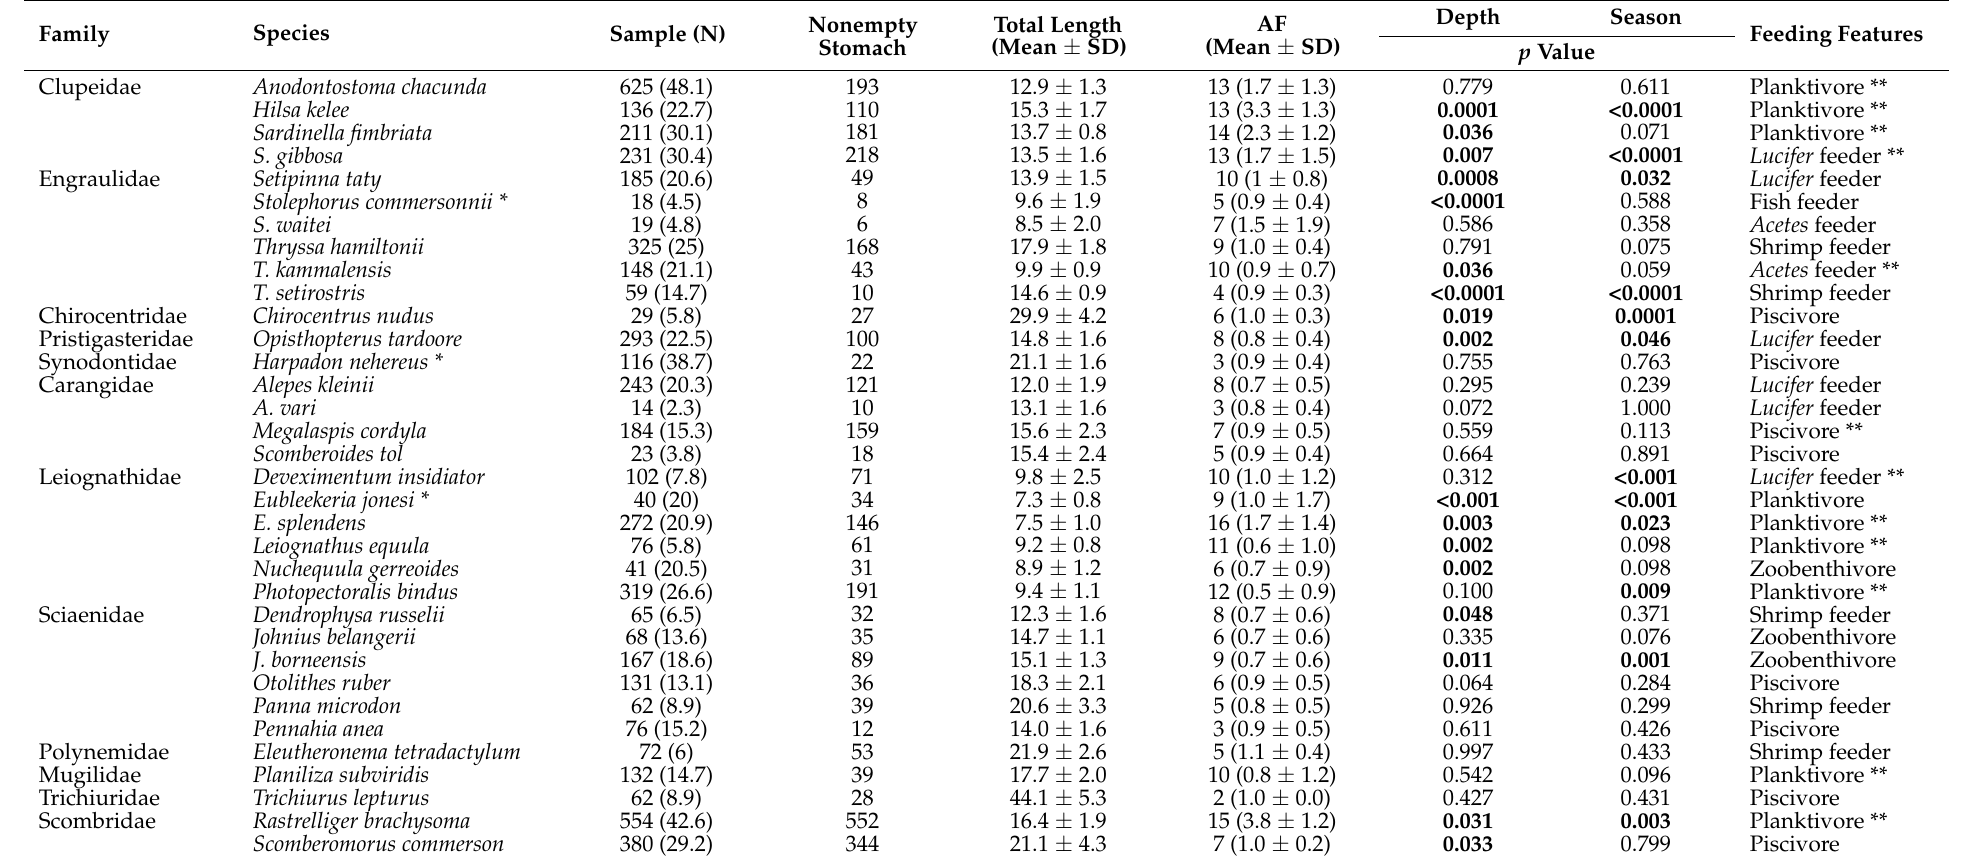
Table 1. Feeding habit and occurrence of anthropogenic debris by fish species off Pattani Bay, in the lower Gulf of Thailand (AF = number of food types; bold indicating statistically significant p value). Parentheses enclose the average number of fish sampled (N) per month. * Statistical analysis applied with month factor when seasonal factor was not available; ** anthropogenic debris